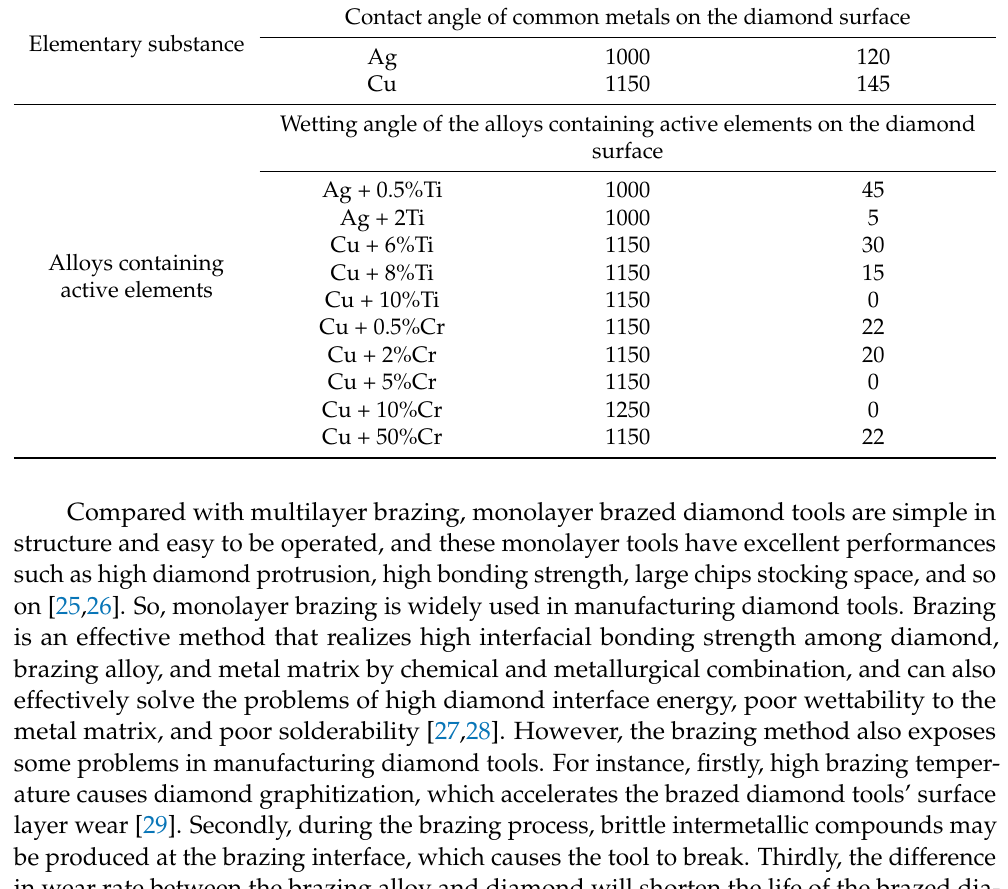
Table 1. The contact angle of common metals and wetting angle of the alloys containing active elements on the diamond surface [19]. Elements Contact angle of common metals on the diamond surface Elementary substance